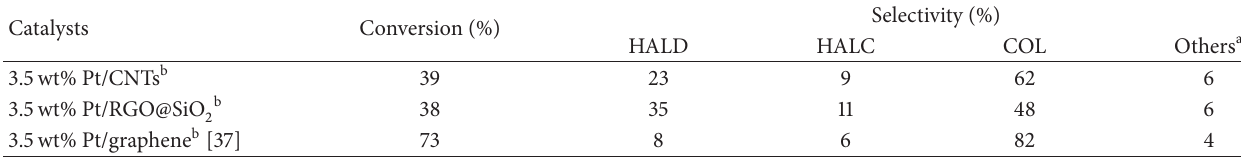
Table 2: The catalytic performances of various catalysts toward the hydrogenation of cinnamaldehyde.